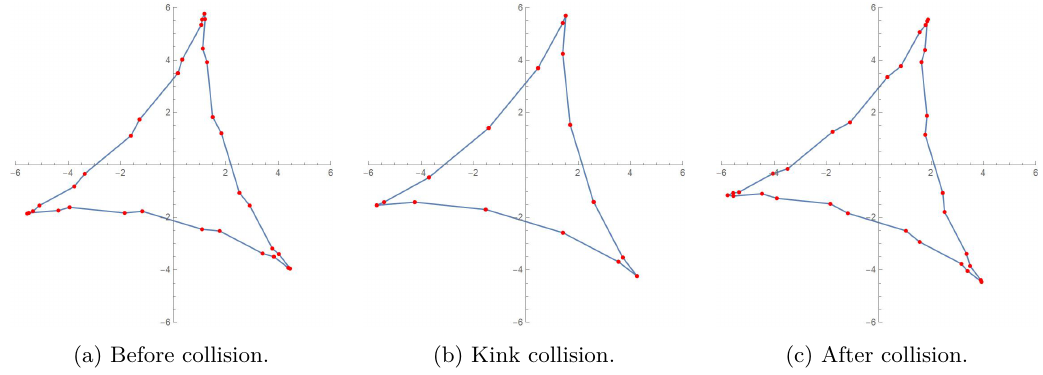
Figure 7 . This segmented string in flat space is obtained by taking Y L of radius 4 and Y R or radius 3. There are 32 kinks and 16 collisions, which in this special case occur all at the same time. This string is an exact solution and approximates a rigidly rotating hypocycloid, which is the flat space analog of the regime 2 Larsen-Sanchez solutions of section